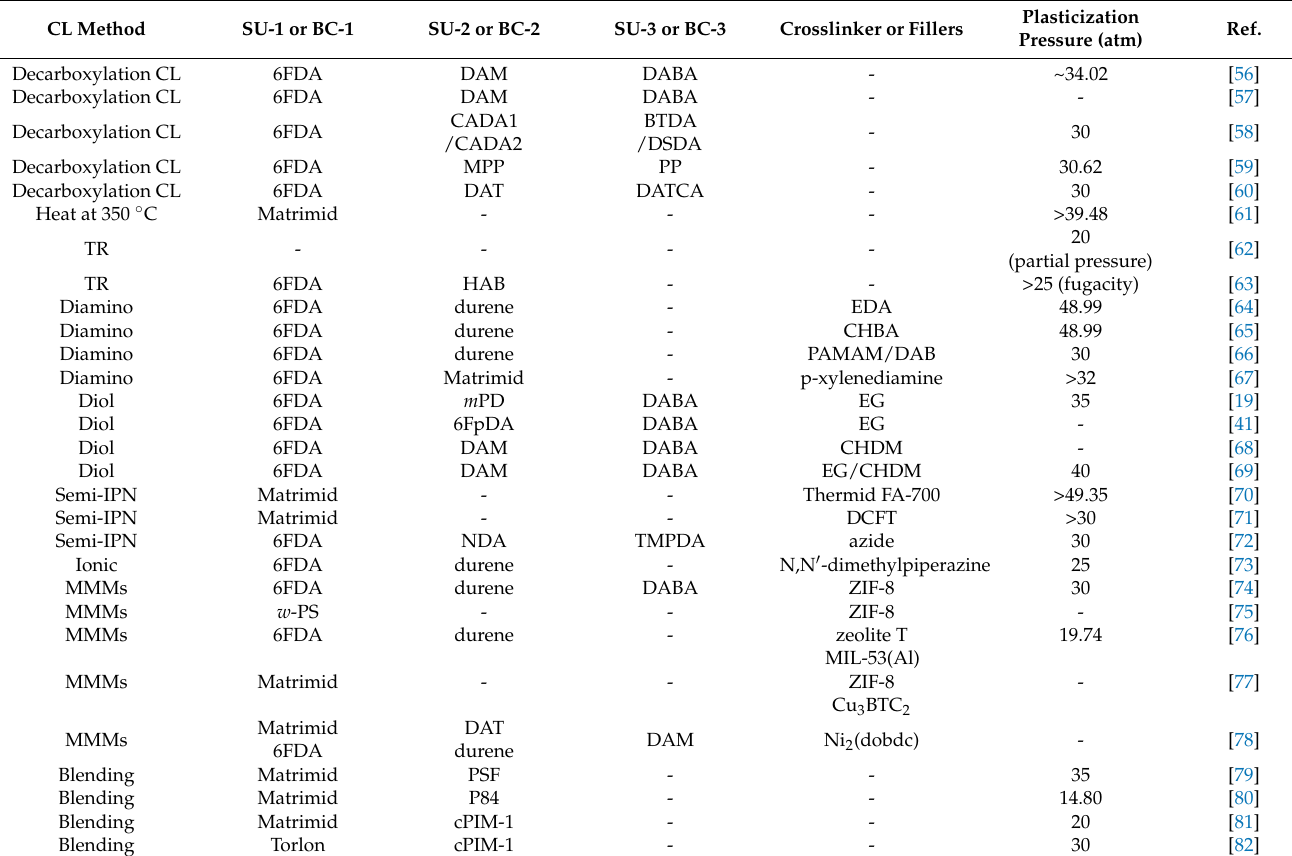
Table 4. Different plasticization pressures reported in the